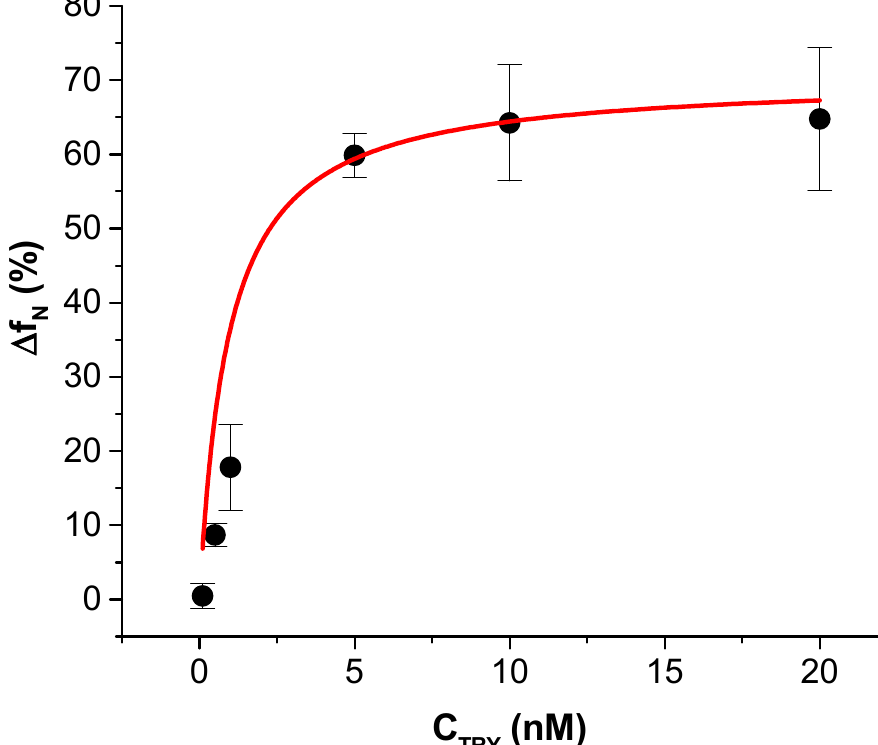
Figure 5. Plot of the normalized changes of the resonant frequency ∆ f N vs. trypsin concentrations, C TRY . Standard deviation values are obtained from three independent experiments. The red line is the fit according to the Langmuir isotherm (Equation (2)) with accuracy R 2 = 0.99. In the paper by Chen et al. [51], the detection of trypsin activity based on the electro- chemical method has been reported. They applied a gold working electrode modified with a short peptide substrate conjugated with graphene oxide (GO) and the thionine redox label. The incubation of the sensor with trypsin for 2 h resulted in cleavage of the peptide substrate, removal of the redox probe, and a decrease of the current amplitude. Although the authors reported a lower detection limit, down to 0.05 nM, and a high selectivity to trypsin, this method has some drawbacks. First, the biosensor was based on the peptide substrate labeled by the graphene oxide (GO)–thionine conjugate, which is not available